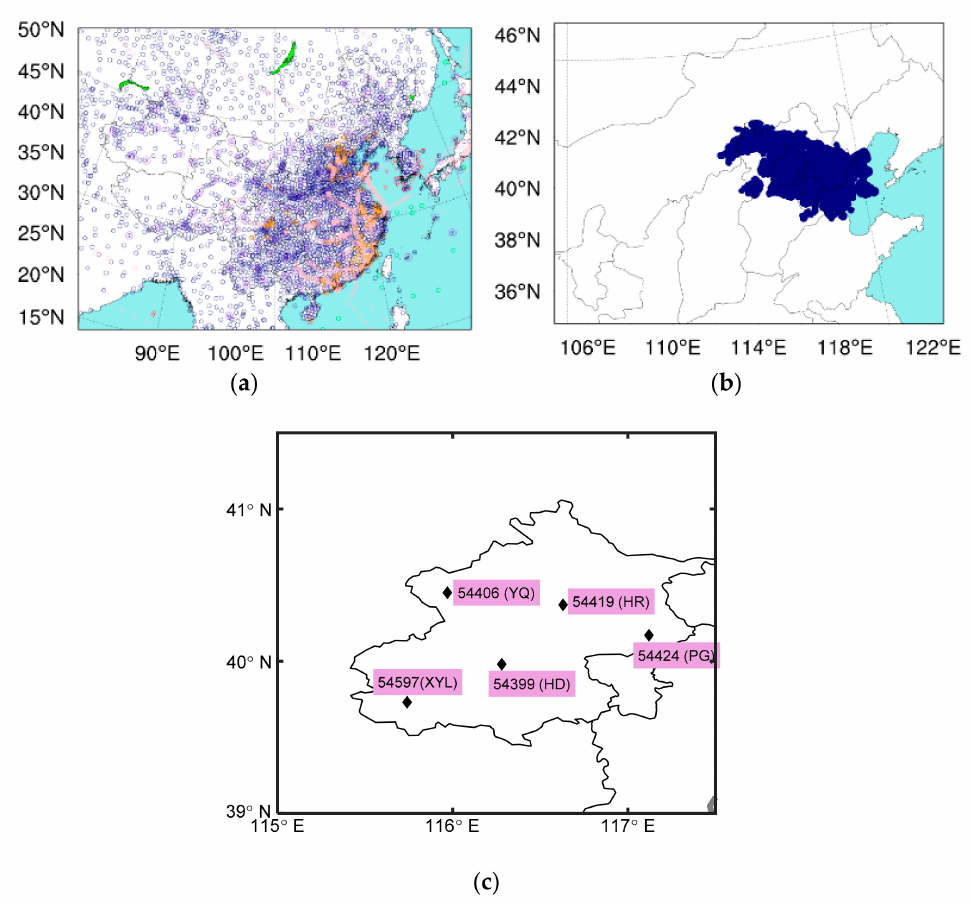
Figure 4. ( a ) The distribution of radiosonde launch sites are shown as purple solid circles; oceano- graphic buoys, wind profile radar observations, and ship-based observations are shown as red circles, orange circles, and green circles; synoptic and aircraft meteorological data relay are shown as dark blue circles and pink circles in Domain 1 of RMAPS-ST. ( b ) The radar locations are represented as dark blue solid circles in Domain 2 of RMAPS-ST. ( c ) Locations of MWRPS sites are represented as black diamonds in